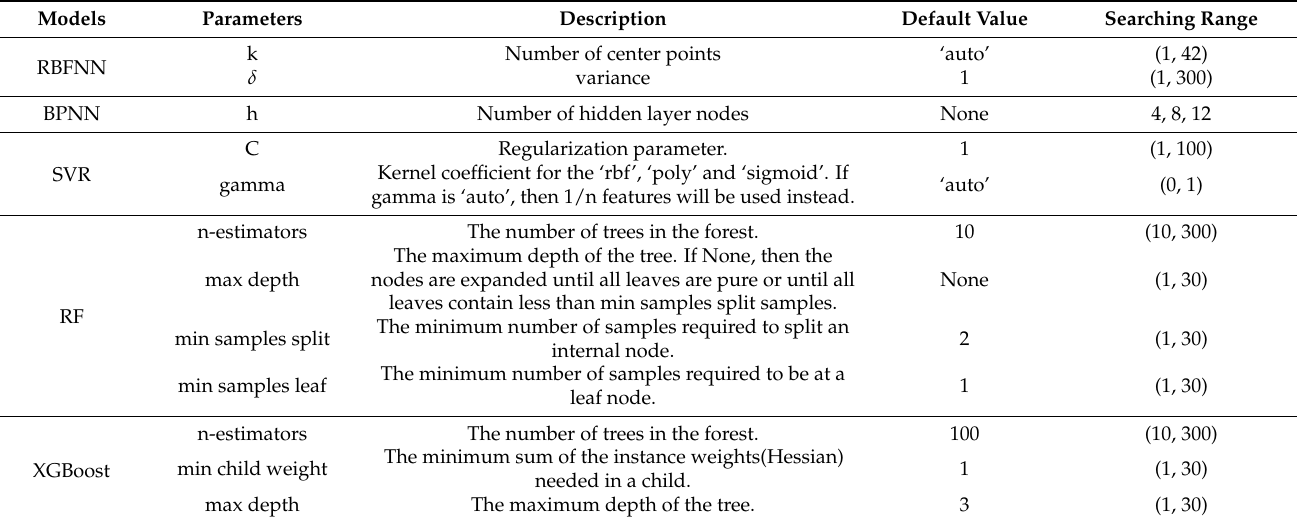
Table 7. The parameter properties of the prediction model and searching ranges.